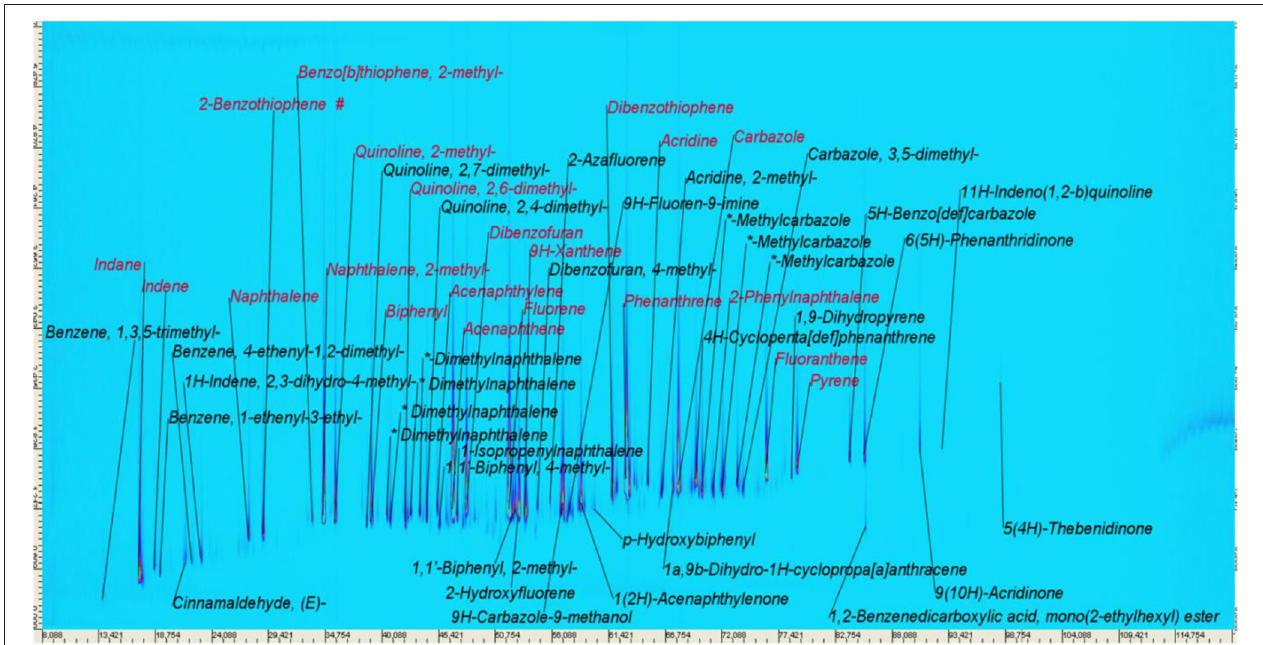
FIGURE 4 | GCxGC-MS Chromatogram of a groundwater sample taken approximately 0.3m above the groundwater/DNAPL interface. Some compounds are identified based on their spectral library match (match factor at least 850), some isomers were not unambiguously identified.